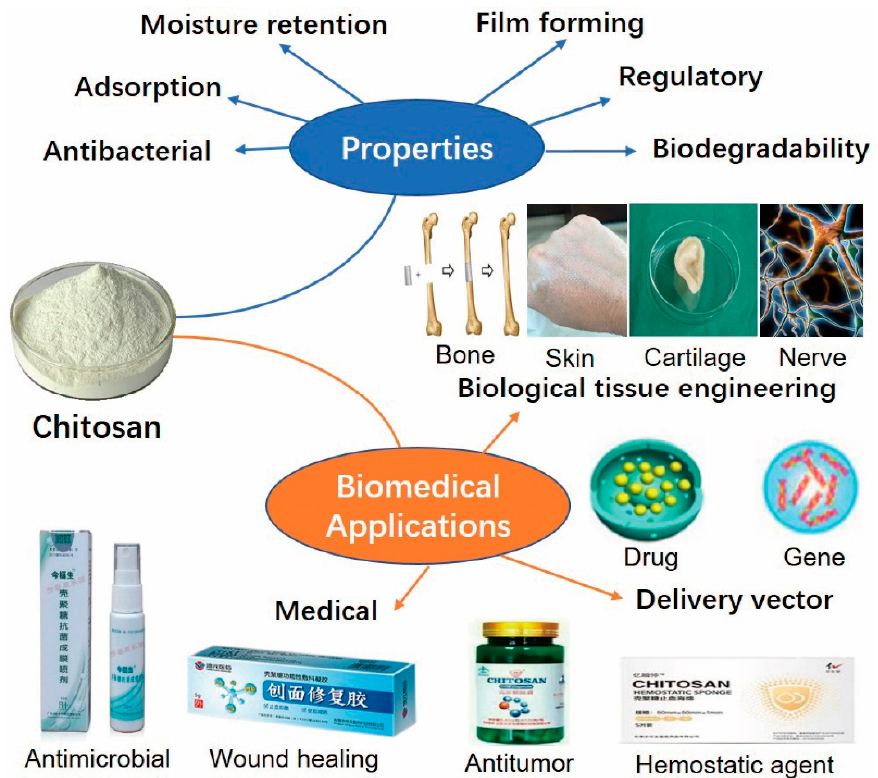
Figure 9. The biological properties of chitosan and its corresponding biomedical applications.